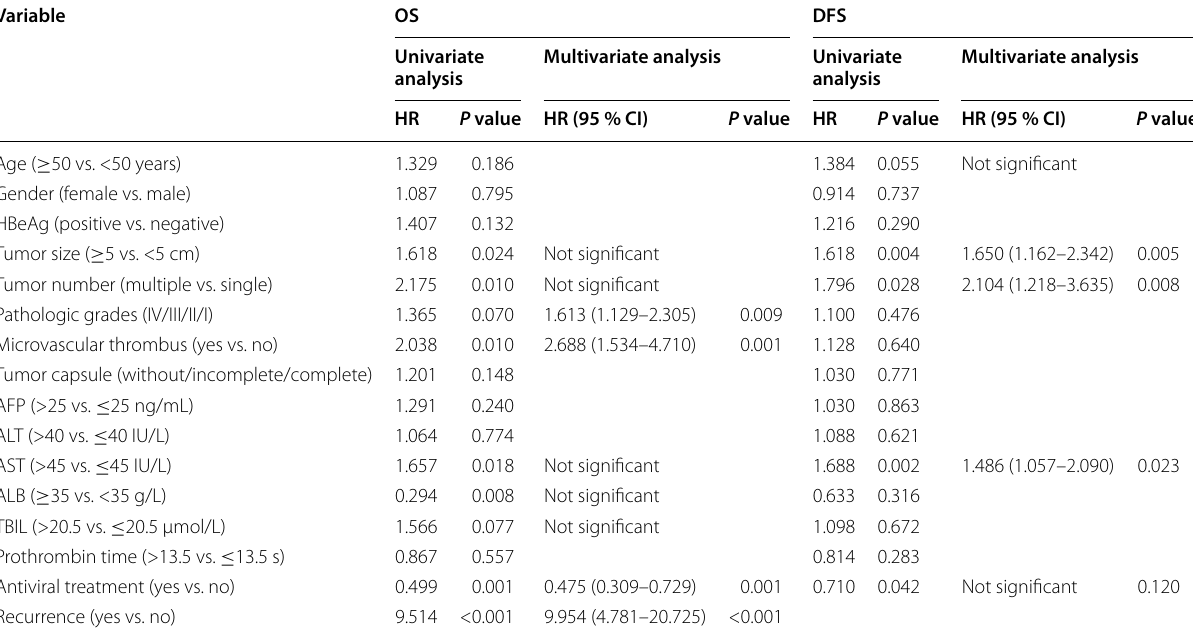
OS overall survival, DFS disease-free survival, CI confidence interval, HR hazard ratio, Antiviral group resection plus postsurgical antiviral treatment group, Non-antiviral group resection alone group, HBV hepatitis B virus, SD standard deviation, HBeAg hepatitis B e antigen, TNM tumor-node-metastasis, AFP alpha-fetoprotein,